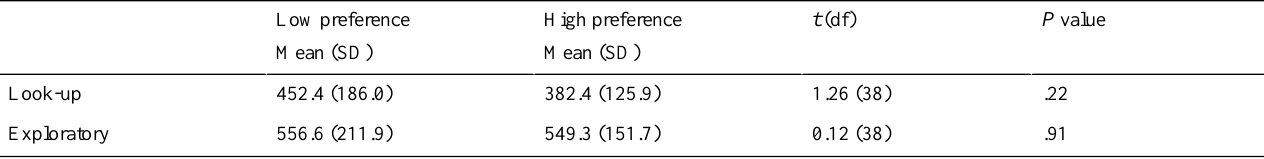
Table 3. Task completion times (in seconds).